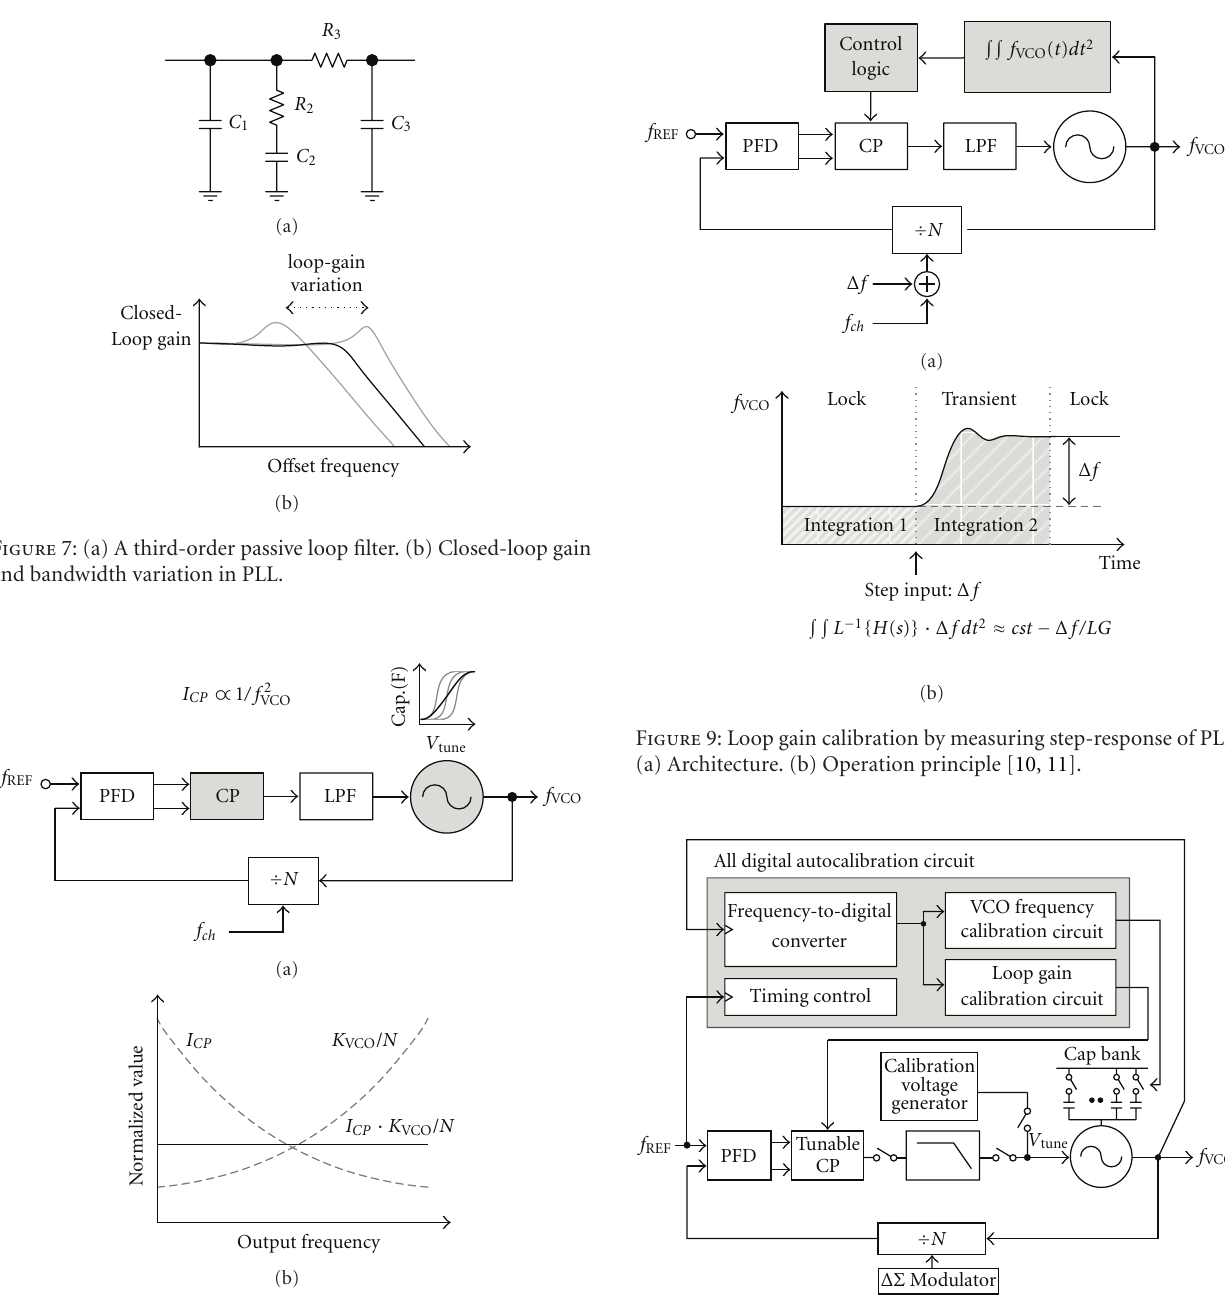
Figure 8: Loop gain compensation by preset pattern of charge pump gain I CP . (a) Architecture. (b) Operation principle [13].